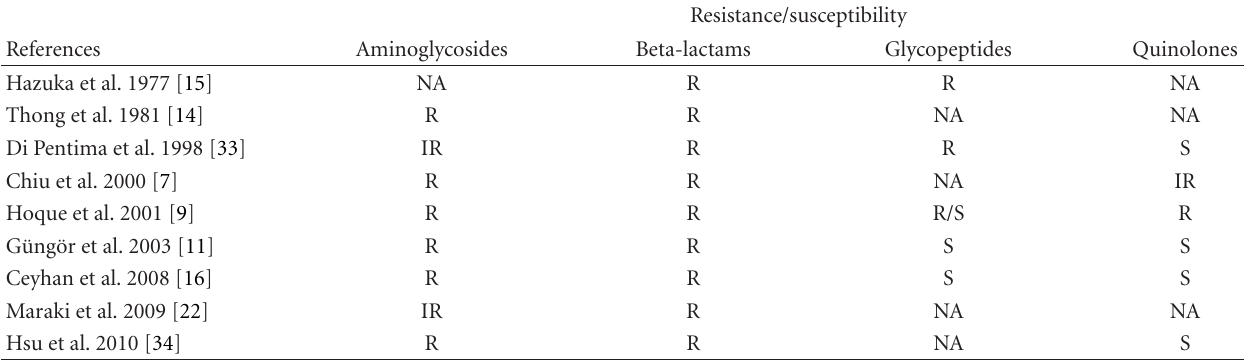
Table 1: The susceptibilities of the strains of C.